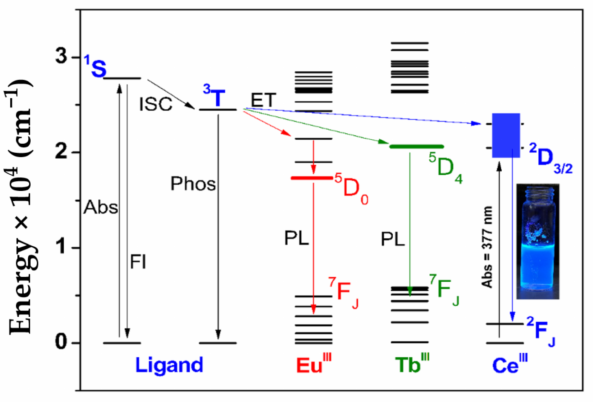
Figure 4. Energy level diagram showing the sensitization mechanism of Eu III , Tb III , and Ce III ions by BimOEt 3 . The nonradiative deactivation pathways are removed for clarity. In the diagram, Abs is absorbance, Fl is fluorescence, PL is photoluminescence, ISC is intersystem crossing, and ET is energy transfer. Energy transfer from the singlet, 1 S, to the excited levels of the Ln III ions is omitted for clarity. The inset shows the intense blue emission of the Ce III complex in ethanol under a handheld 365-nm UV lamp